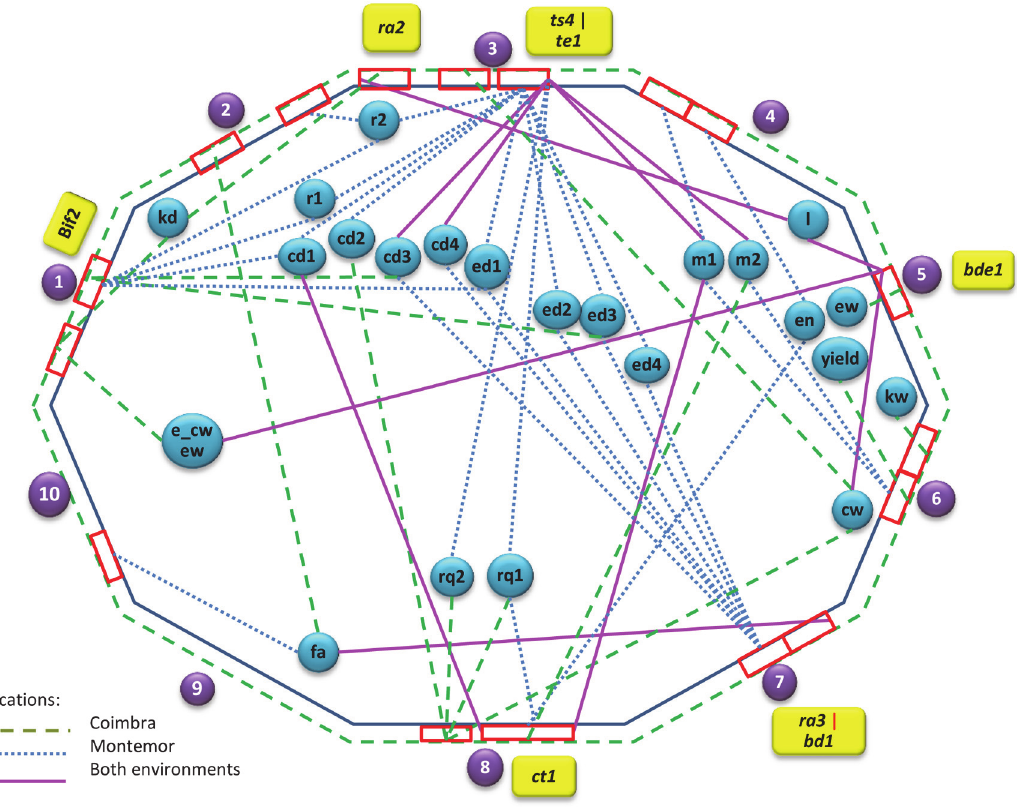
Fig 2. Representation of the ear fasciation and related traits QTL regions per maize chromosome, with indication of respective detection environment. For each chromosomal region, the respective candidate genes are